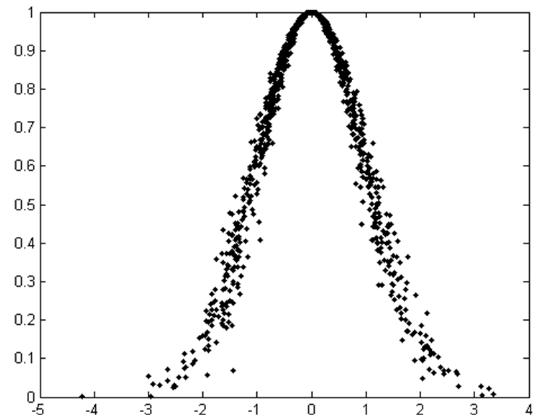
Figure 2. Sketch map of a membership